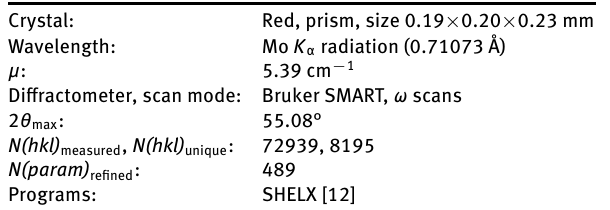
Table 1: Data collection and handling. Crystal: